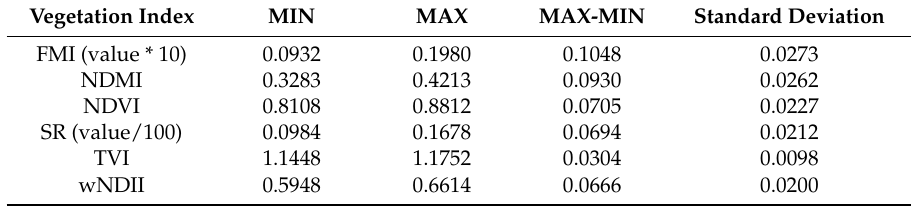
Figure 17. Time series of the vegetation indices for the area affected by the bark beetle and the wind calamity ( a ); and the statistical information ( b ) (the average from the Sumava National Park) (Source: Own work). Table 7. Statistical information about the average values in the areas with minimal disturbance in the Low Tatras